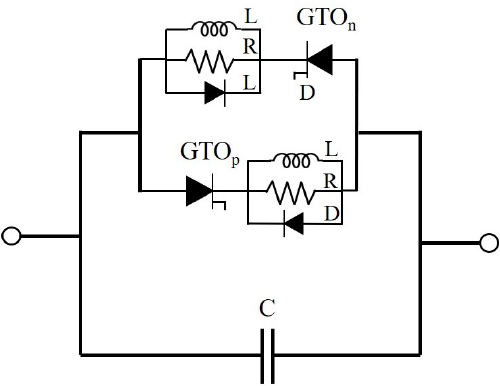
Figure 10. GTO-Controlled Series Capacitor (GCSC) basic scheme. Based on Reference [11].